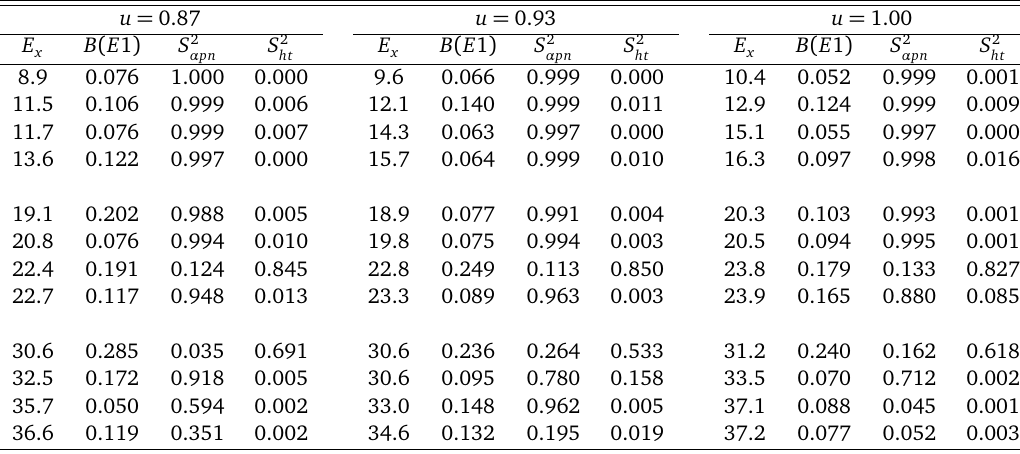
Table 1: Excitation energy E in MeV, B ( E 1 ) in e 2 fm 2 and α + p + n and h + t spec- x troscopic factors in 6 Li with different u parameters. The results with u = 0.93 are adopted from Ref. [ 3 ]